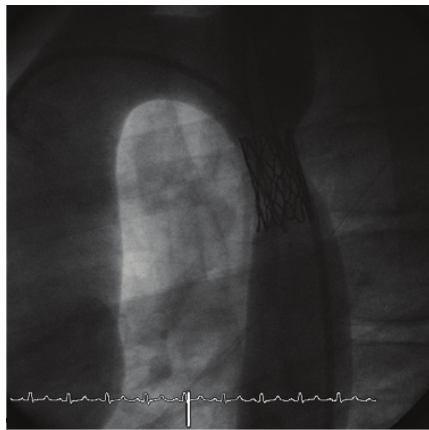
Figure 4: Lateral view: growth-induced narrowing of the previously implanted stent.